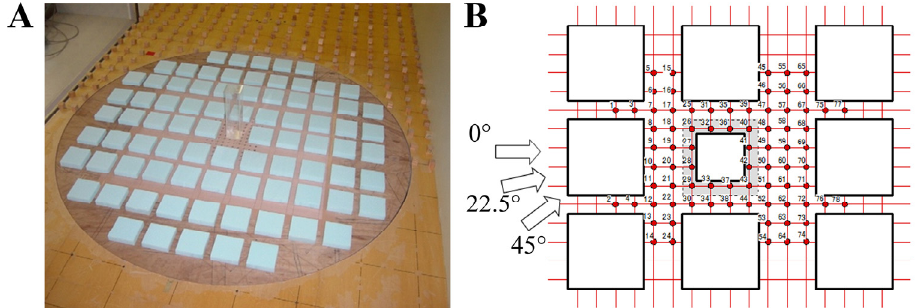
Figure 1. ( A ) Wind tunnel experiment model of AIJ case D; ( B ) diagram of the target area around the central high-rise building and measurement points.